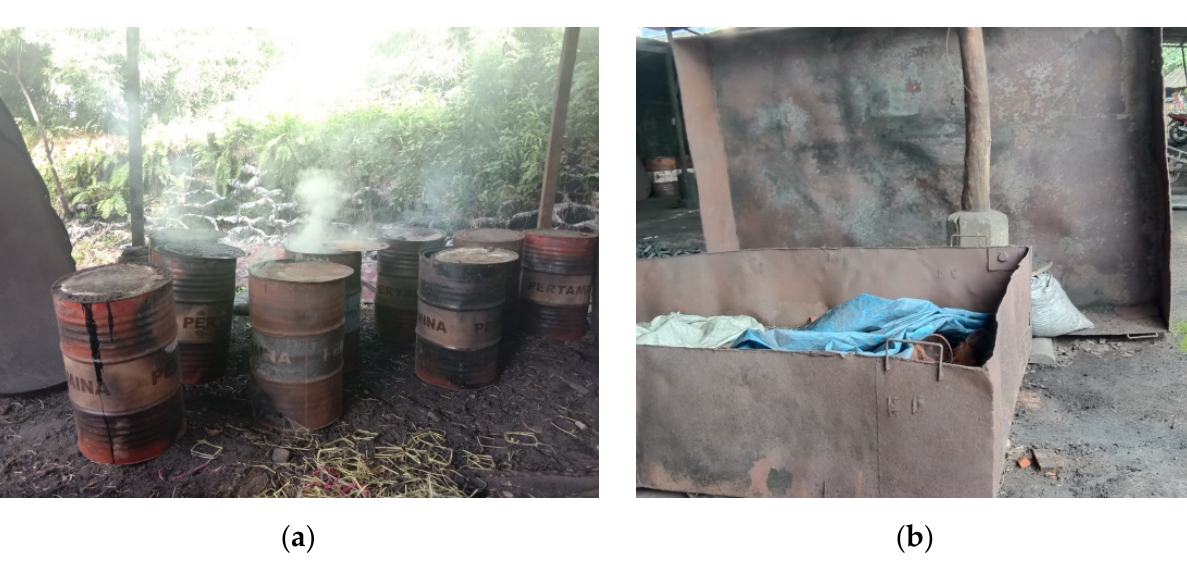
Figure 3. ( a ) Drum furnaces and ( b ) roasting kiln.